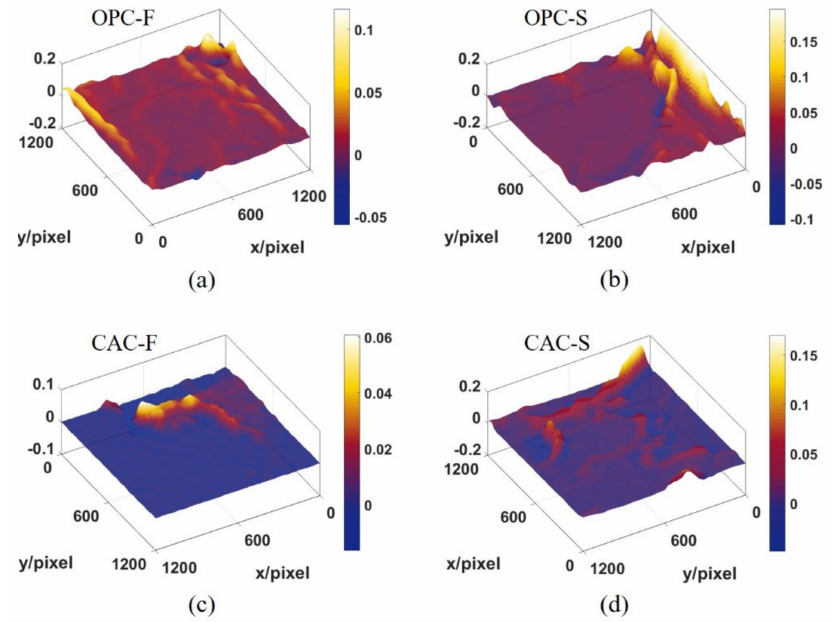
Figure 7. Volumetric strain fields of ( a ) OPC-F, ( b ) OPC-S, ( c ) CAC-F and ( d ) CAC-S at peak load, respectively.